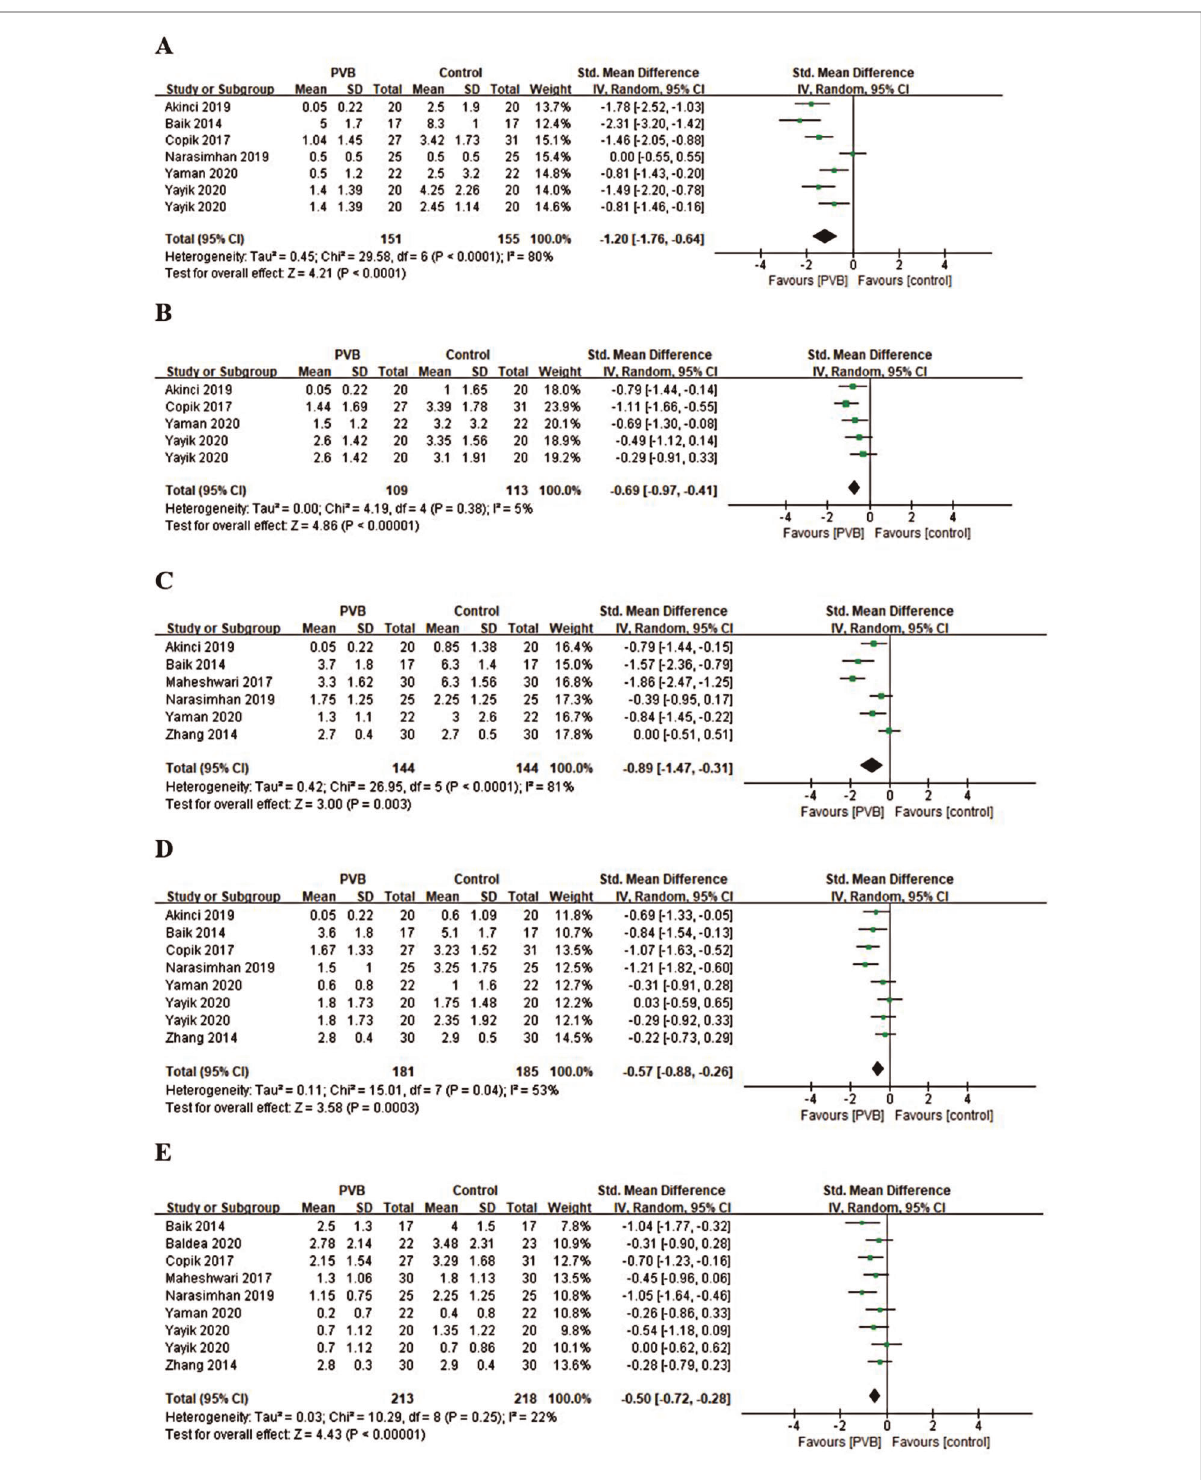
FIGURE 4 Forest plot of pain scores at rest at ( A ) 1 h, ( B ) 4 h, ( C ) 6 h, ( D ) 12 h, and ( E ) 24 h timepoints after